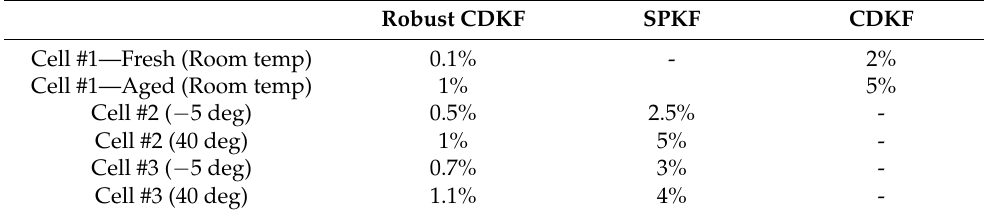
Table 6. Comparison of the SoC estimation errors for cells #1, 2, and 3.